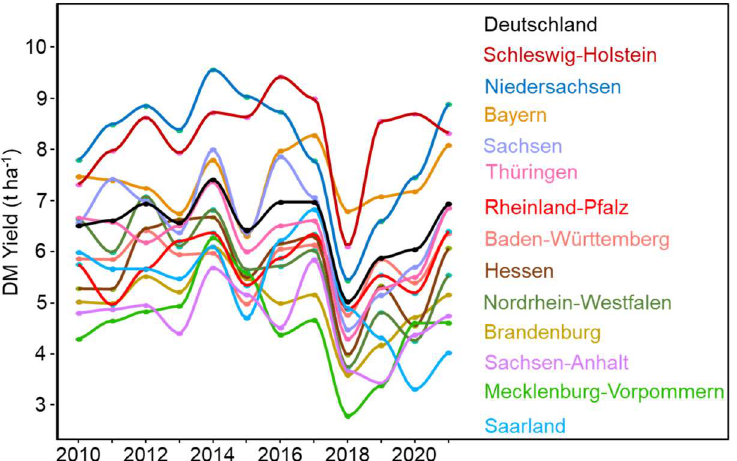
Figure 1. Annual dry matter (DM) yields for the different states of Germany obtained from the Statistisches